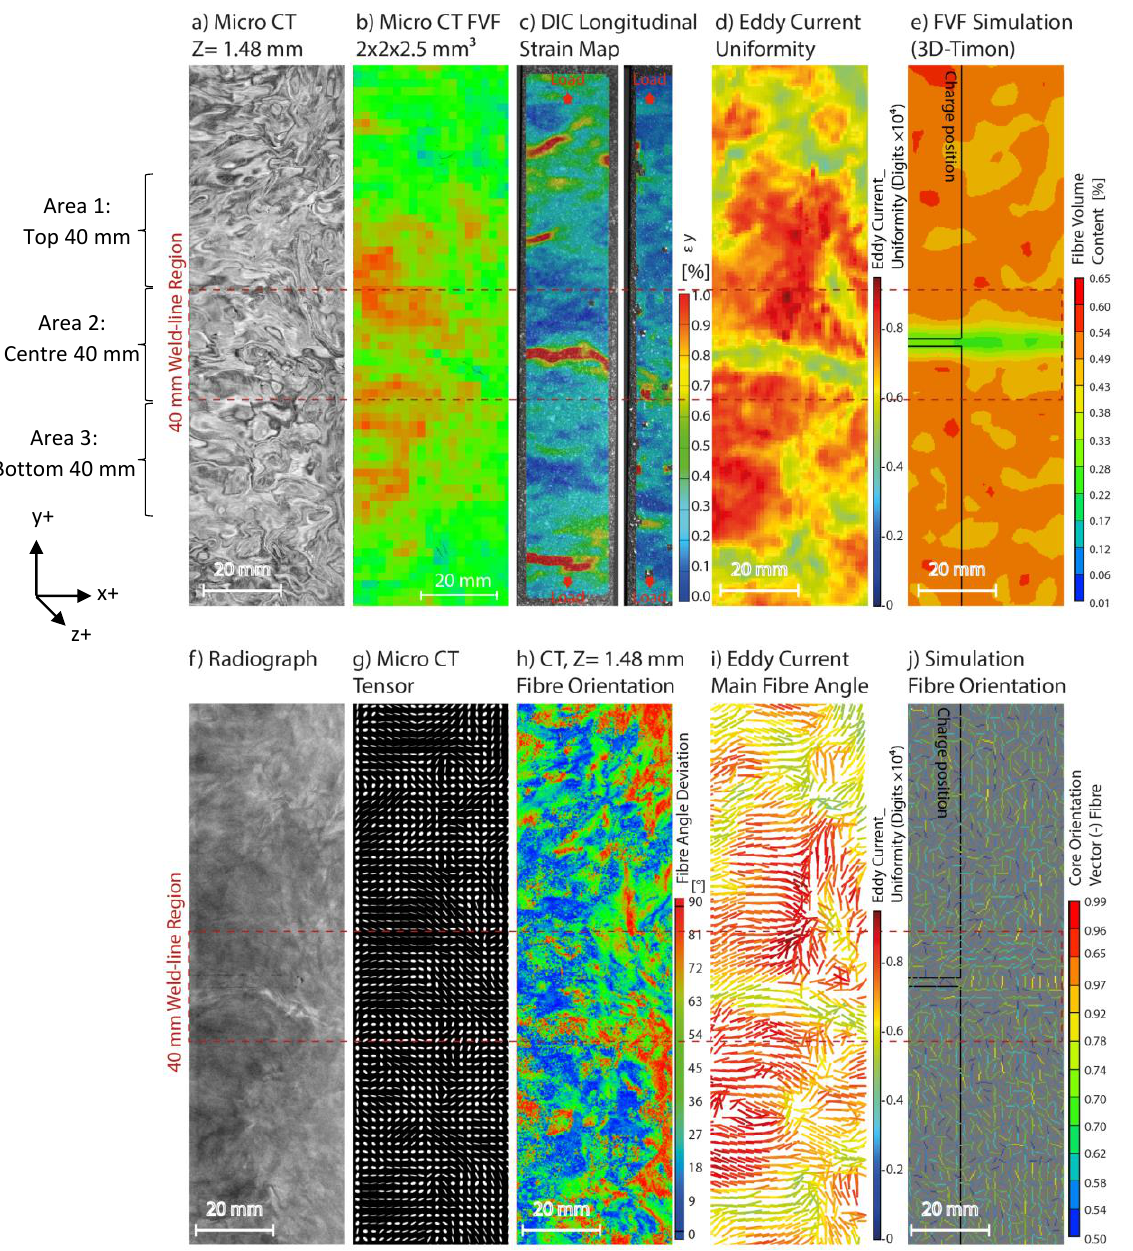
Figure 16. Comparing the fibre angle and fibre volume fraction results for the Butt specimen, ( a ) micro CT image (at z = 1.45 mm), ( b ) micro-CT relative FVF, ( c ) DIC longitudinal strain map of two adjacent tensile coupons (max strain at 0.5%), ( d ) eddy current uniformity (fibre areal weight), ( e ) simulated fibre areal weight, ( f ) radiograph, ( g ) fibre tensors (micro-CT), ( h ) micro-CT fibre orientation (at z = 1.45 mm), ( i ) eddy current principal fibre angle, and ( j ) simulated fibre orientation. The WLD area is highlighted with a red dashed box. Dimensions of area shown are 39 mm × 135